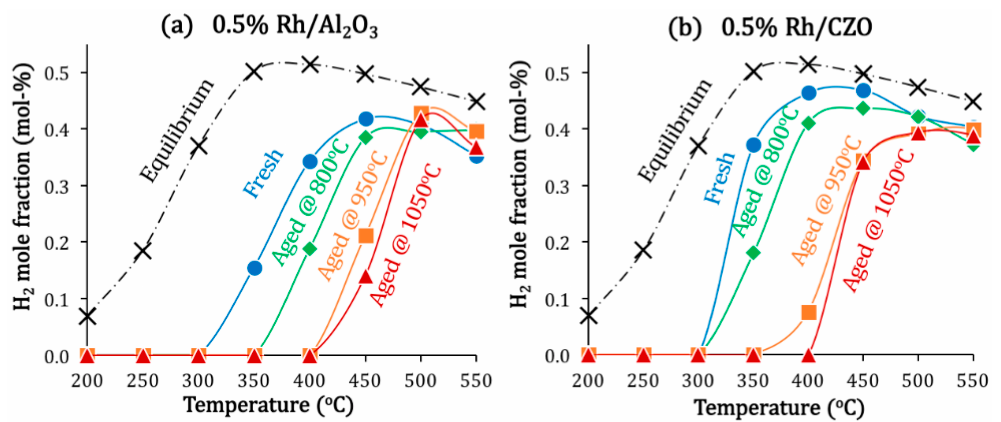
Figure 6. Catalyst activity of fresh and aged ( a ) 0.5% Rh/Al 2 O 3 and ( b ) 0.5% Rh/CZO Catalyst activity is plotted in terms of H 2 mole fraction as a function of reaction temperature (200 °C–550 °C).